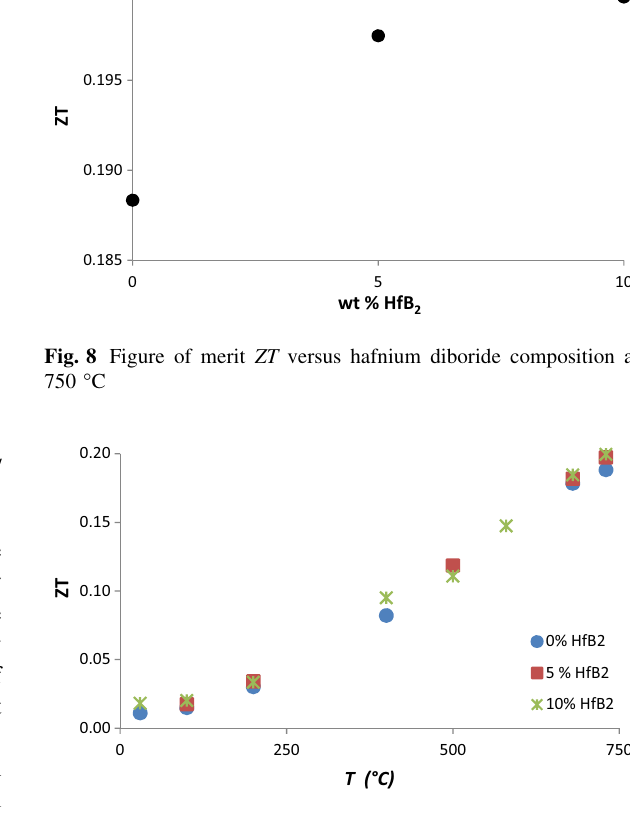
Fig. 9 Figure of merit ZT versus temperature of boron carbide/HfB 2 composites for 0–10 wt% hafnium diboride